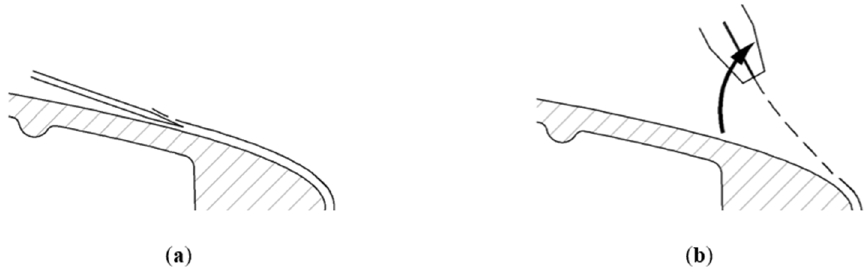
Figure 10. Scheme of tearing off the shield during preliminary tests: ( a ) crack initiation with a chisel, ( b ) tearing off the shield with universal pliers.